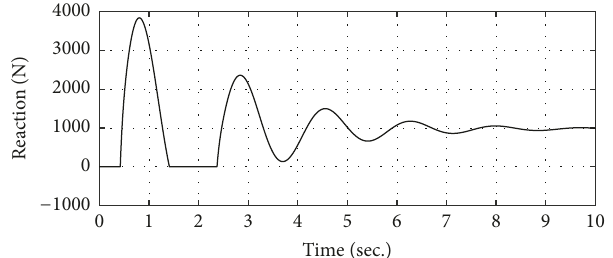
Figure 10: Time history of reaction 𝑅 in viscoelastic system shown in Figure